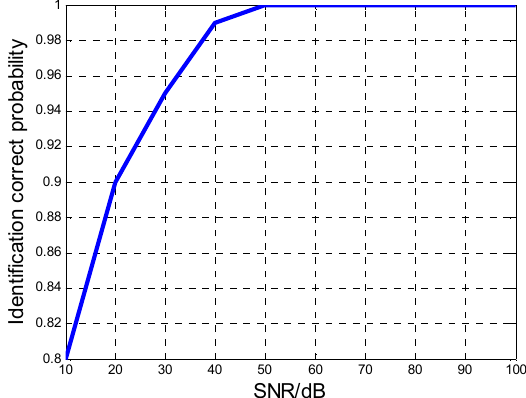
Figure 3. The identification correct probability of aircraft number versus SNR.